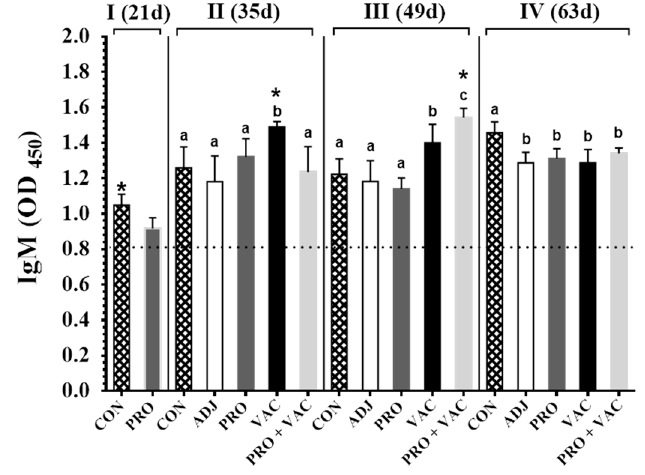
Figure 3. ELISA indirect for measurement IgM in serum of Nile tilapia collected in the periods: [I] probiotic diet feeding, [II] vaccination, [III] revaccination (booster) and [IV] survival post-infection with S. agalactiae serotype Ib. Statistical differences between control and treated groups ( p < 0.05). (CON: control; ADJ: adjuvant; PRO: probiotics; VAC: vaccinated; PRO + VAC: probiotics + vaccine). * Significant difference in period II Kruskall–Wallis ( p > 0.001) and period III, IV Kruskall–Wallis ( p > 0.001). a–c Significant difference in Dunn test between groups within each period. OD 450 : Optical Density at 450 nm.